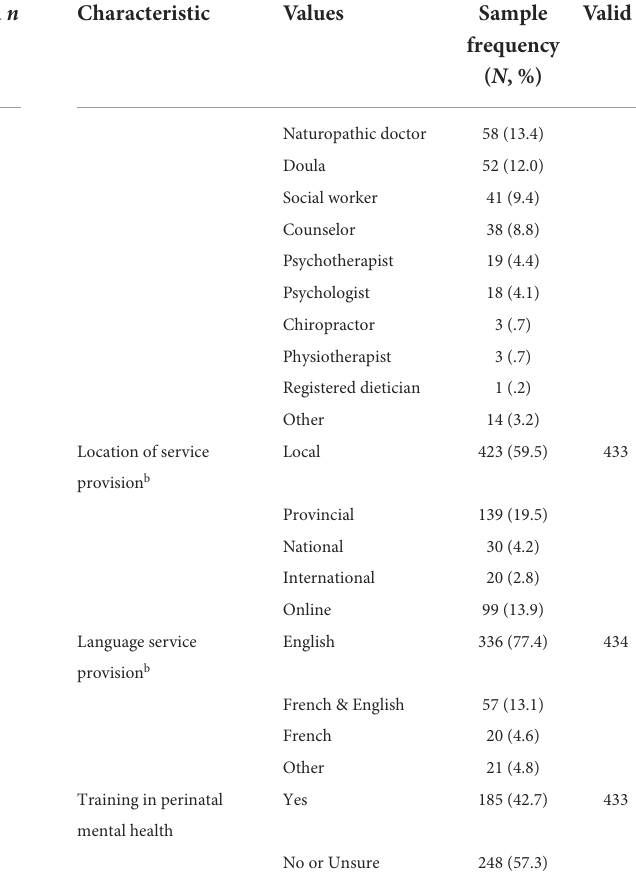
TABLE 1 Demographics and professional characteristics of survey